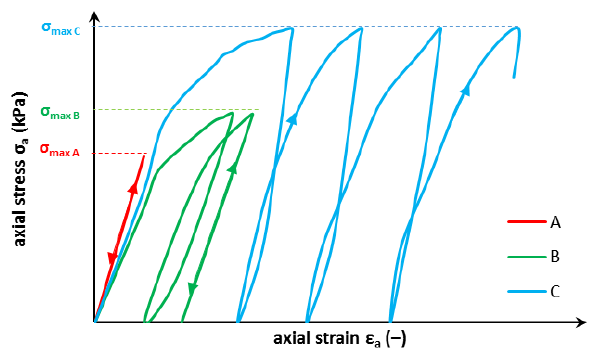
Figure 1. Shema of stress-strain response of a material to cyclic loading, A—pure elastic response, B—shakedown, C—ratcheting during the cyclic loading.